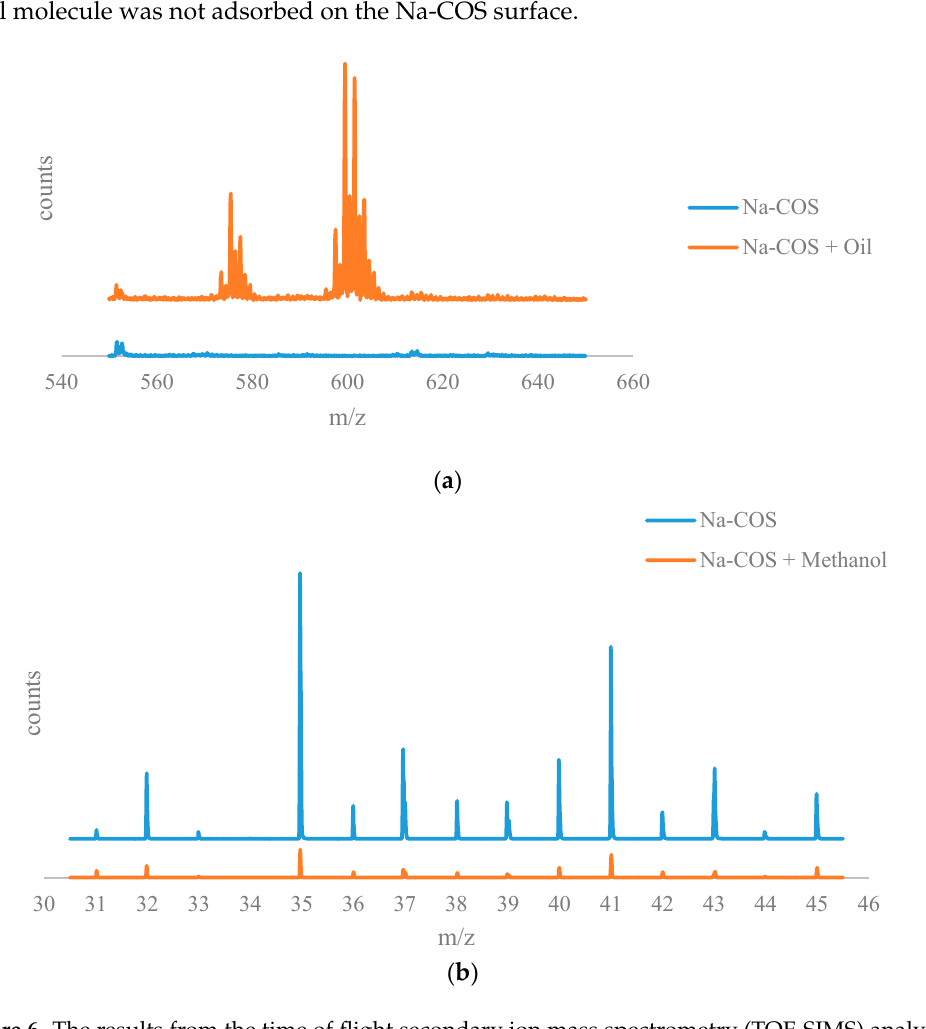
Figure 5. SEM images of COS ( a ) and Na-COS ( b ).